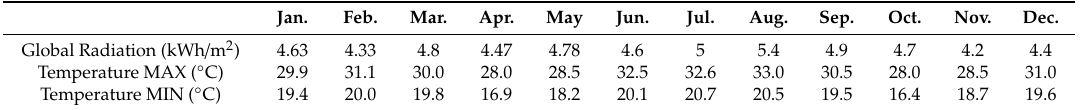
Table 1. Global radiation and average temperature in